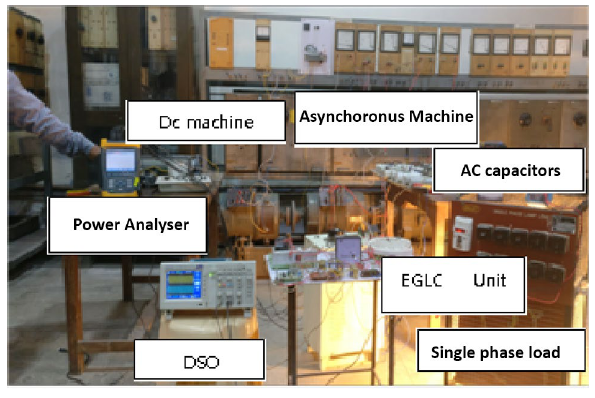
Fig. 3 Photograph of the complete generating unit along with EGLC unit